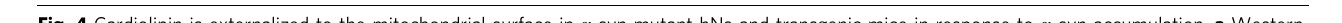
Fig. 4 Cardiolipin is externalized to the mitochondrial surface in α -syn mutant hNs and transgenic mice in response to α -syn accumulation. a Western analysis of lysates from corrected and A53T cells at DIV 14 and DIV 60 labeled for total α -syn, PS129, TH (DA neuronal marker), nestin (NPC marker) or GAPDH show that levels of PS129-modi fi ed α -syn are elevated in A53T hNs at DIV 14 and remain elevated at DIV 60 relative to corrected cells. b , c Mitochondria were puri fi ed from A53T cells and genetically corrected cells at both DIV 14 and DIV 60. Lysates were then separated based on TX-100 solubility (soluble) or urea solubility (insoluble). Western analysis of A53T cells shows elevated soluble α -syn at the mitochondria relative to corrected cells at DIV 14 and DIV 60 (denoted by ** and * respectively). Quanti fi cation of soluble and insoluble α -syn levels in mitochondrial fractions normalized to Coomassie ( c ). Data represent mean ± s.e.m. * P < 0.05, ** P < 0.01 by ANOVA followed by Tukey ’ s post hoc test, n = 4. d , e Micrographs of corrected and A53T-mutant NPCs expressing the negative charge probe RPRE-RFP and CL-GFP show RPRE-RFP translocation from a primarily plasma membrane localization in isogenic-corrected hNs to a punctate intracellular localization in A53T hNs in tight cellular localization with CL-GFP ( d ). Quanti fi cation of percent total cell number with colocalized RPRE-RFP and CL-GFP ( e ). Data represent mean ± s.e.m. ** P < 0.0001 by t -test, n = 3 coverslips over 2 independent differentiations, DIV: 14; scale bar: 10 μ m. f , g Fluorescence resonance energy transfer (FRET) from CL-GFP to RPRE-RFP in